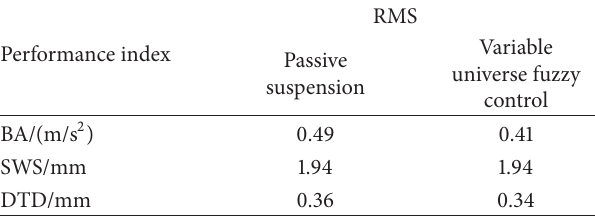
Table 6: Suspension performance of B-class random